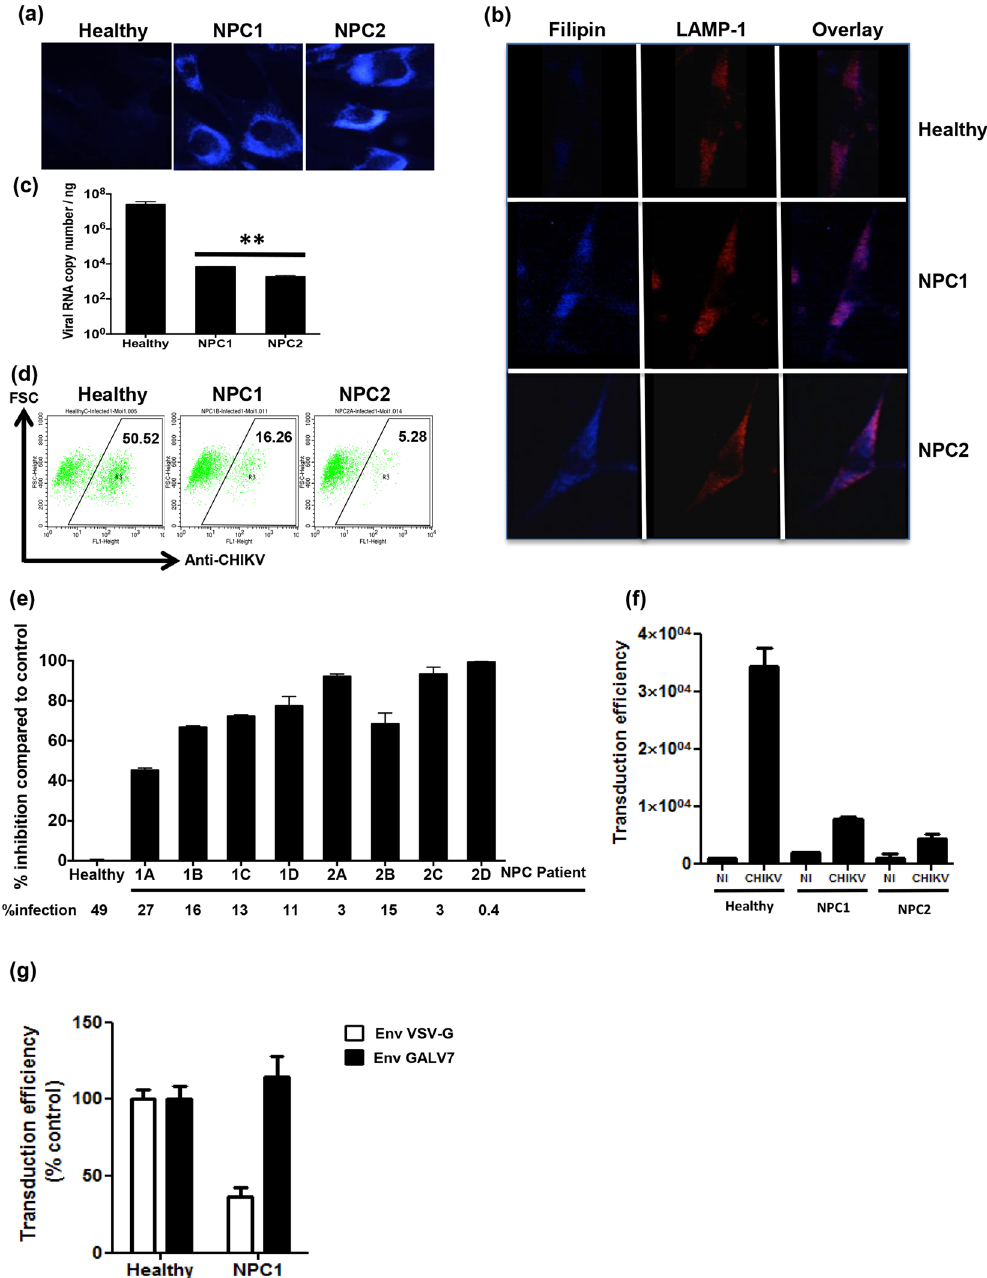
Figure 4. NPC1 and NPC2 proteins are crucial for CHIKV replication. ( a ) The phenotypes of NPC-deficient cells were confirmed by filipin and cholesterol accumulation examined by fluorescence microscope. ( b ) Healthy, NPC1- and NPC2-deficient cells were fixed and labeled with filipin (blue) or LAMP-1 (red). Colocalization of cholesterol and LAMP-1 are shown in violet. ( c and d ) Healthy, NPC1- and NPC2-deficient cells were infected with CHIKV La Réunion strain (MOI 1). After 24 h, the production of viral RNA and production of virus structural proteins were measured by real-time RT-PCR and FACS analysis, respectively. The data represent mean ± SD from three independent experiments. ** p < 0.01 when compared to healthy. ( e ) Healthy, NPC1- and NPC2-deficient cells were infected with CHIKV La Réunion strain (MOI 1). After 24 h, percentage of CHIKV infected cells was measured by flow cytometry; reduction of percentage of CHIKV infected cells compared to cells from healthy control is shown. ( f ) Primary fibroblasts derived either from healthy individuals or from patients with NPC1 or NPC2 deficiencies were challenged with HIV particles pseudotyped either with CHIKVenvelope glycoproteins. Transduction of the cells was monitored by quantification of GFP in the cells after 48 h. Values are normalized according to protein content in the samples and are the mean of triplicated ± SD. NI is for non transduced cells. ( g ) Normal skin fibroblasts or NPC1 deficient cells were transduced by VSV-G- or GALV-pseudotyped particles and processed as in ( f